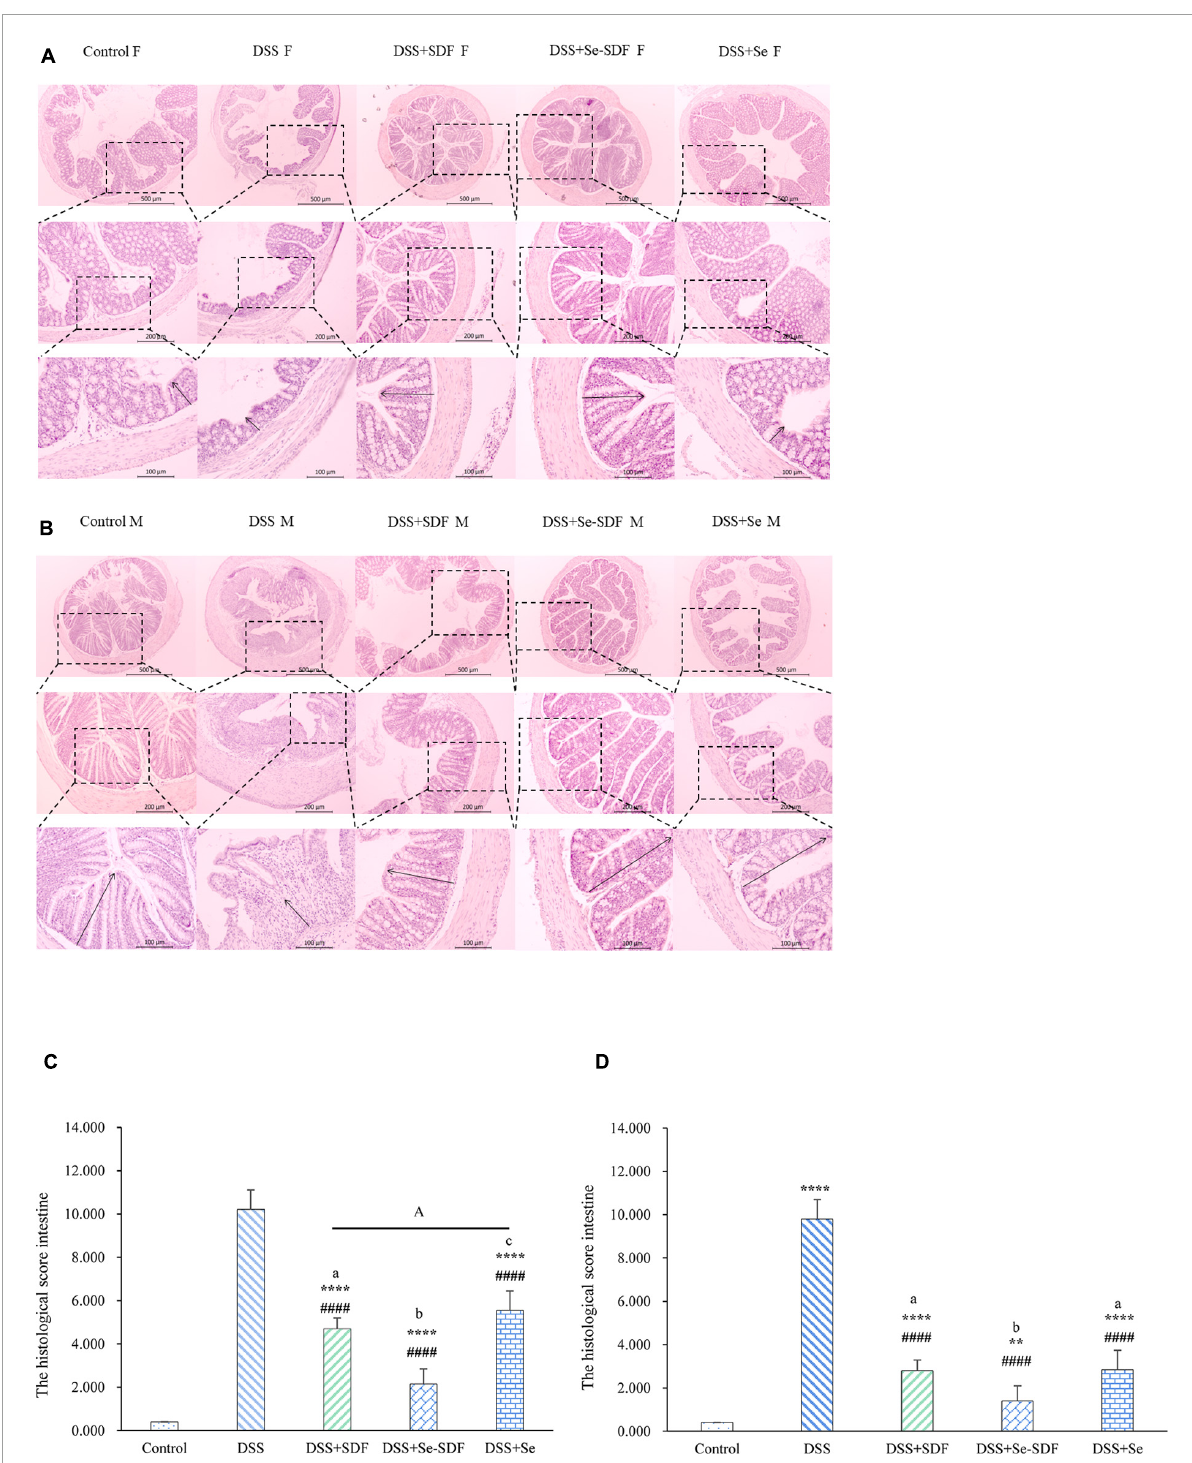
FIGURE2 Effect of Se-SDF on histopathological changes in mice with DSS-induced colitis. (A) Histological scores of female mice. (B) Histological scores of male mice. (C) Histological analysis of female mice. (D) Histological analysis of male mice. Data are expressed as mean ± SD ( n = 3). * p < 0.05, ** p < 0.01, *** p < 0.001, **** p < 0.0001 vs. control group. # p < 0.05, ## p < 0.01, ### p < 0.001, #### p < 0.0001 vs. DSS group. Different letters indicate significant differences between groups ( p <